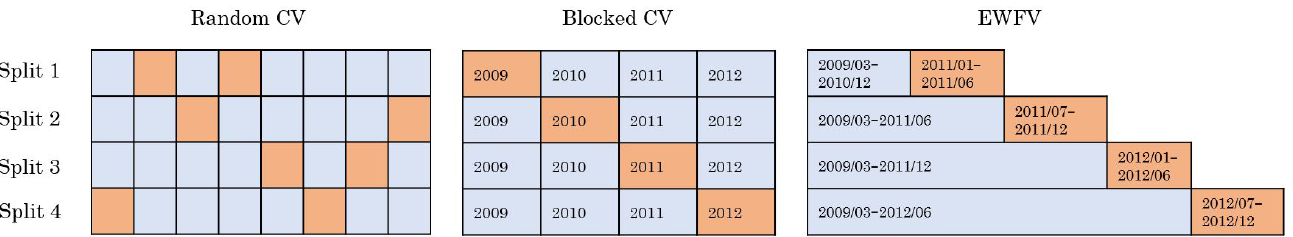
Figure 3. Illustration of validation schemes. Each split consisted of the corresponding validation fold (orange) and the training fold (blue). Since there were four data splits, we used four validation folds for each